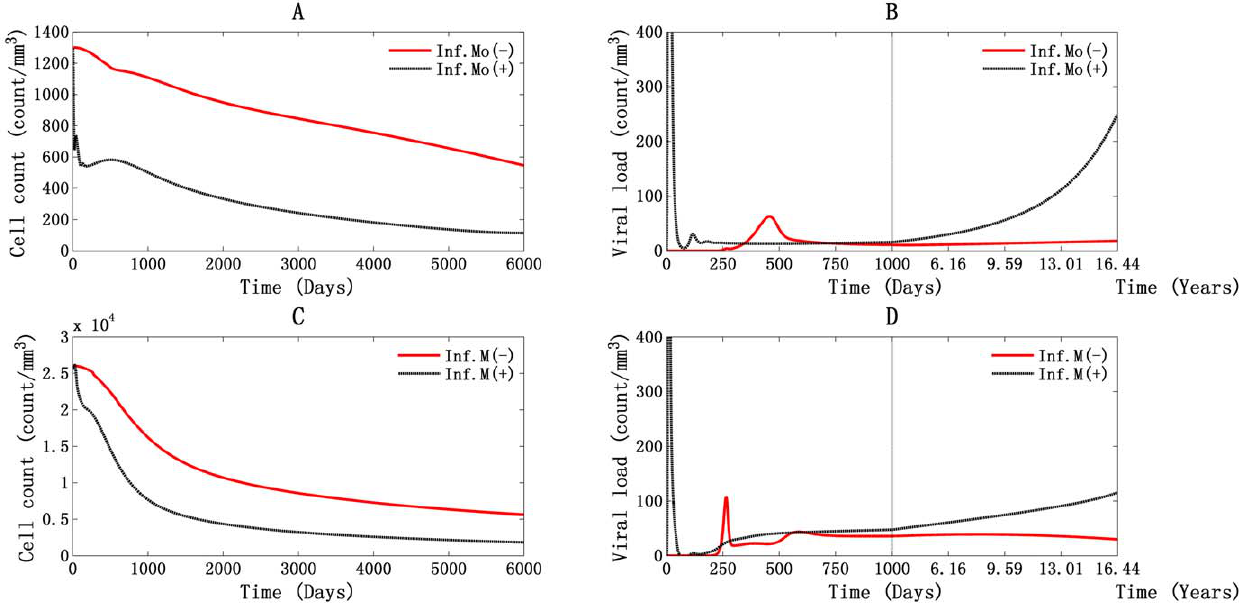
Figure 9. Effects of infected monocytes/macrophages on the T4 cell count and viral load. Panels A and B stand for PB, and panels C and D stand for LNs.